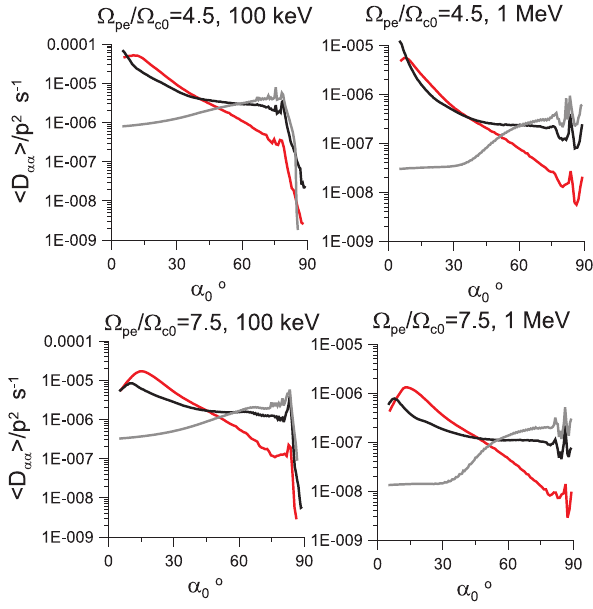
Fig. 17. Diffusion coefficients calculated with realistic root-mean- square wave amplitudes B w (λ) for L = 4 to 5 for Kp < 3 are shown by red curves. Black and grey curves show h D i B calculated with a constant rms B w = 6pT with a realistic g(θ) and with h θ i ∼ 0,